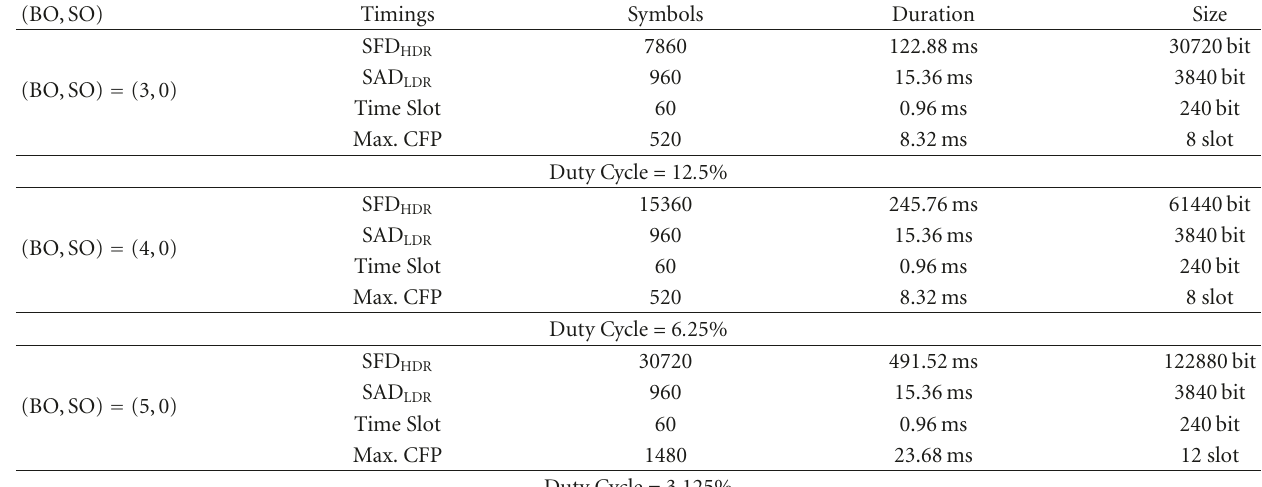
Table 4: 802.15.4 timings for a data rate of 250 kbps with